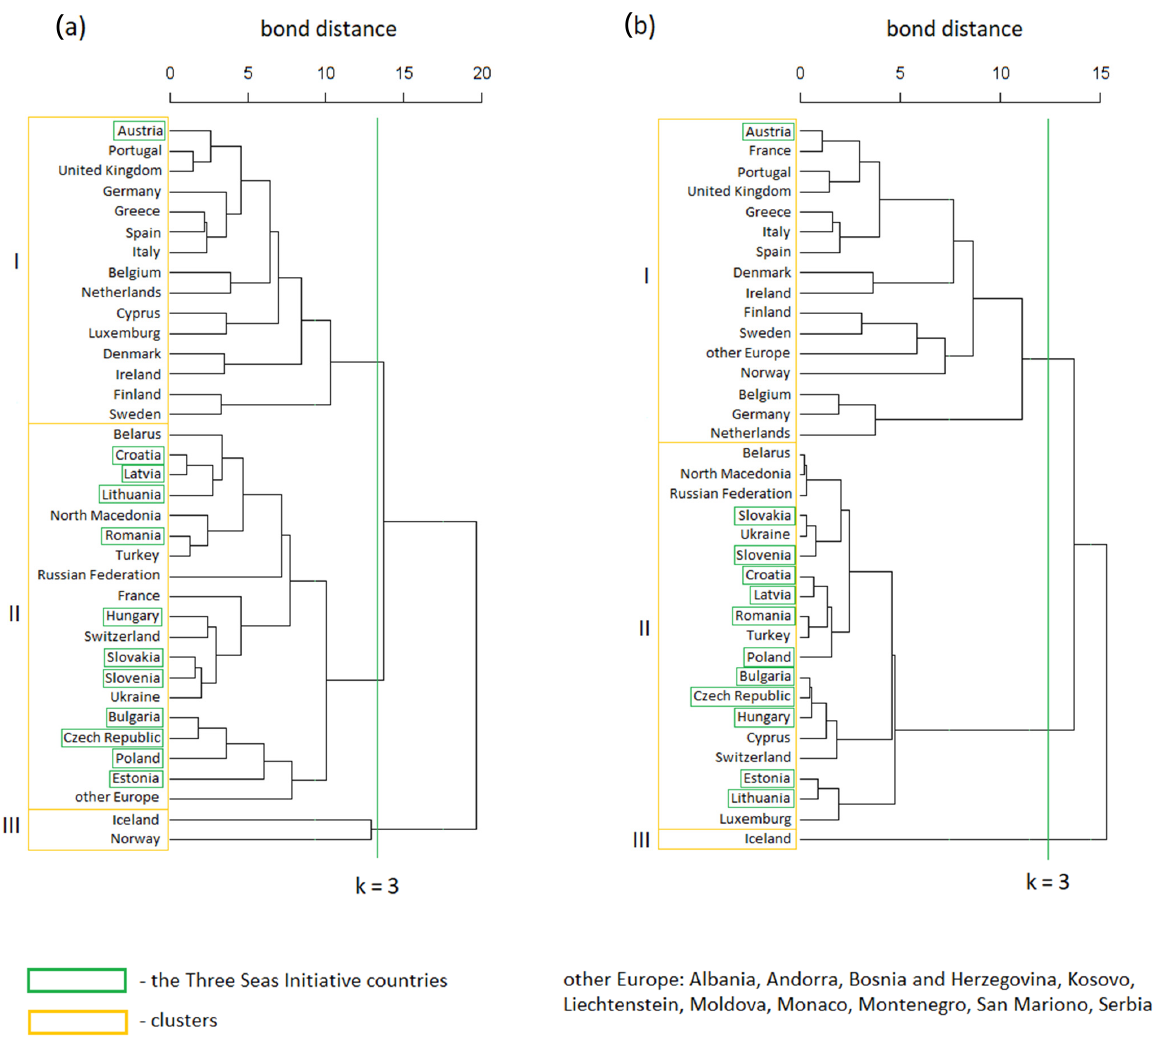
Figure 1. Dendrograms of production and consumption rates for renewable and non-renewable energy carriers ( a ) and rates describing only renewable sources ( b ).